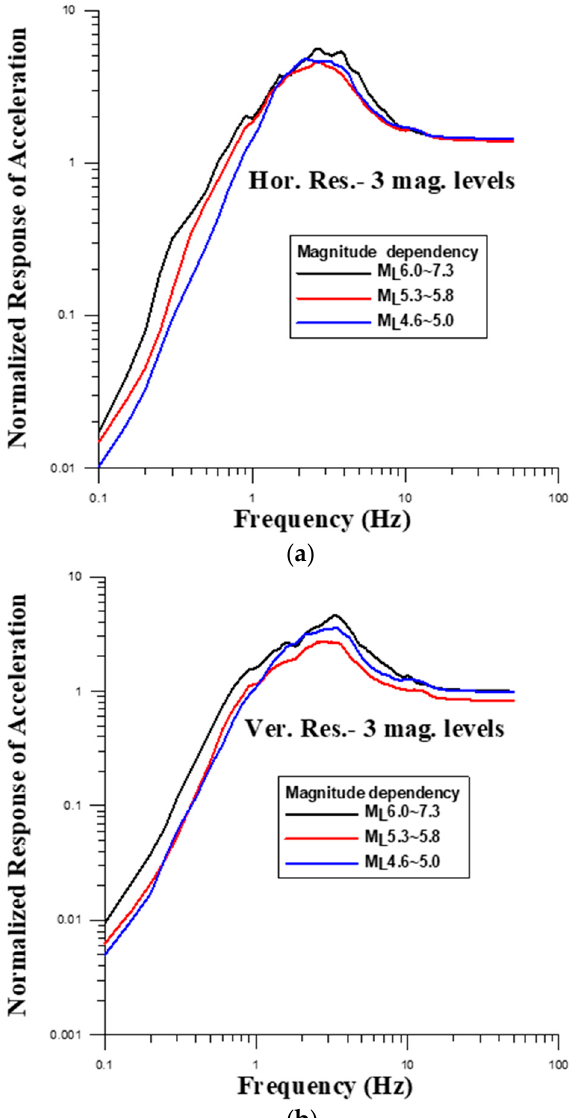
Figure 7. Normalized ( a ) horizontal and ( b ) vertical response spectra of three groups of earthquake magnitude (15 events): M L 6.0~7.3 (black solid), 5.3~5.8 (red solid), and 4.6~5.0 (blue solid), respectively.